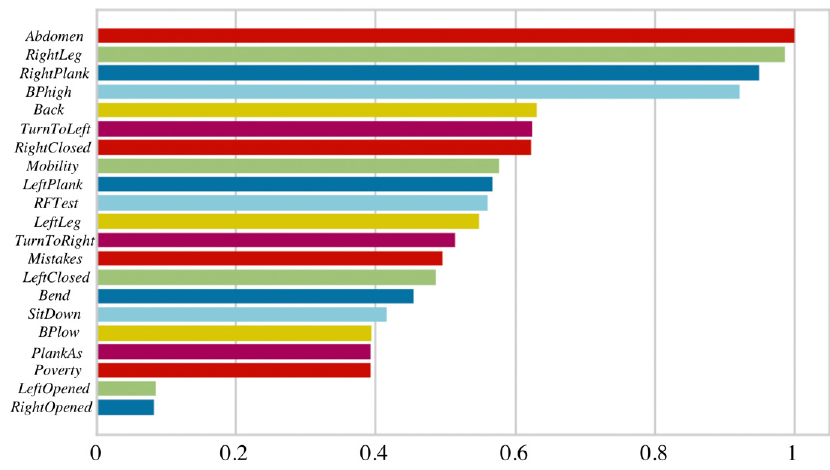
Figure 5. Feature importance for the RF model.